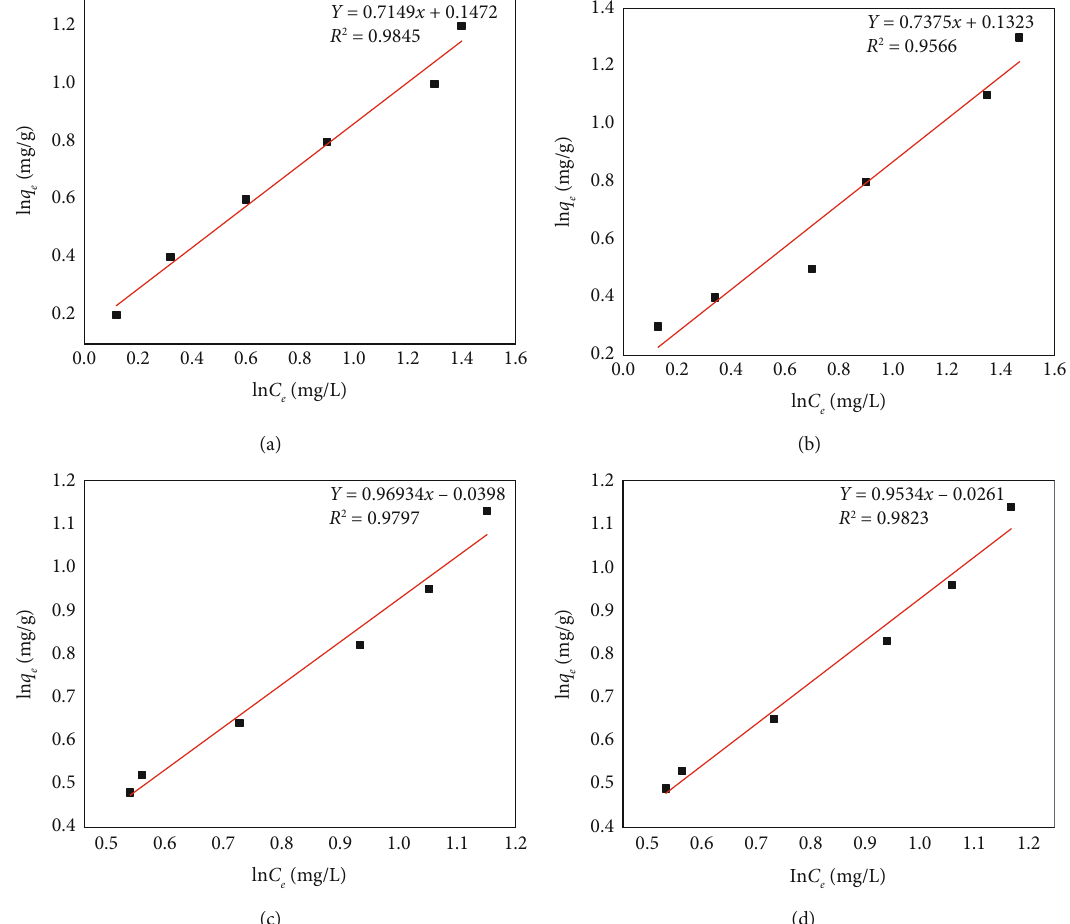
Figure 7: Freundlich adsorption isotherms for fl uoride adsorption by (a) TAADFP at 450 ° C, (b) TAADFP at 500 ° C, (c) TAADFP at 550 ° C, and (d) TAADFP at 600 °